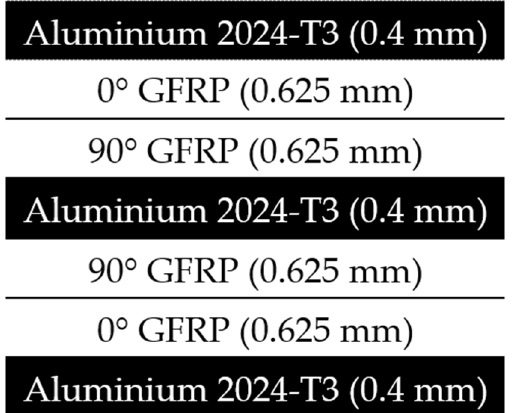
Figure 1. Schematic diagram of GLARE 3/2-0.4.